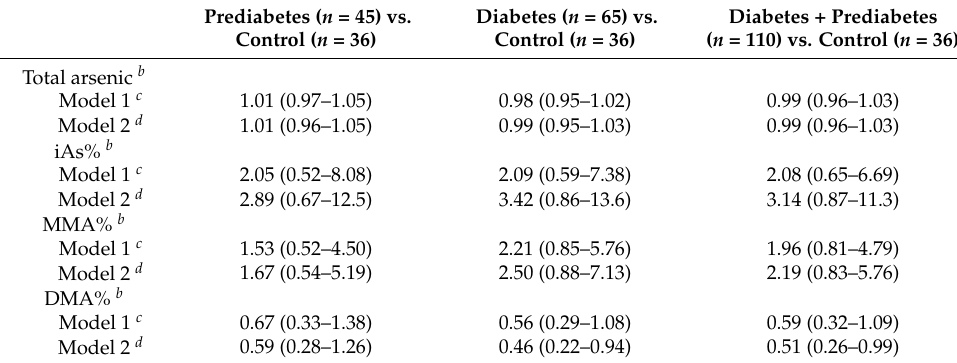
Table 2. Association (odds ratio (OR) a (95% confidence interval (CI)) between urinary arsenic and metabolism indices and diabetes.